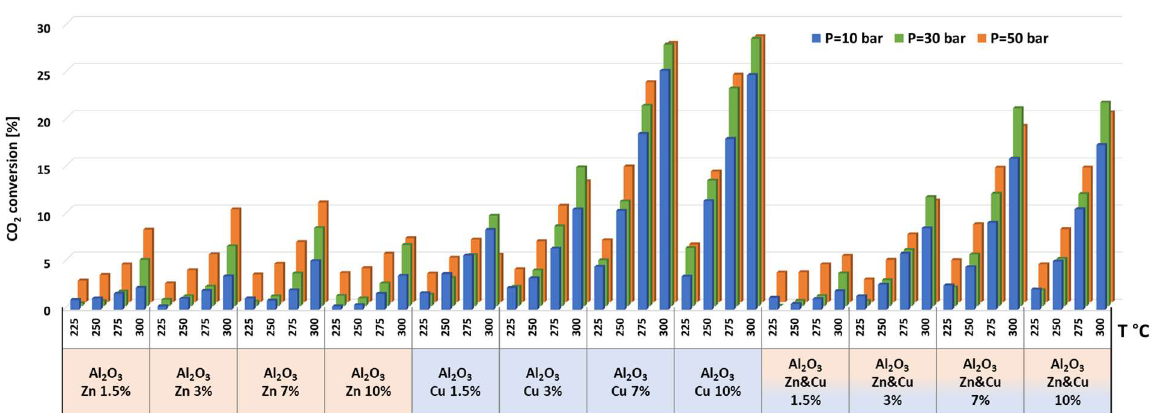
Figure 5. CO 2 conversions for all catalysts at pressures of 10, 30, and 50 bar and temperatures of 225, 250, 275, and 300 °C.